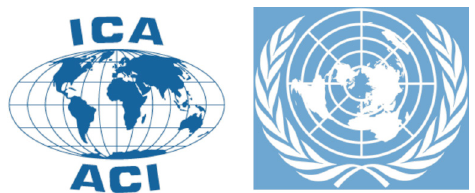
Fig. 23. Map projections in the logos of various organizations